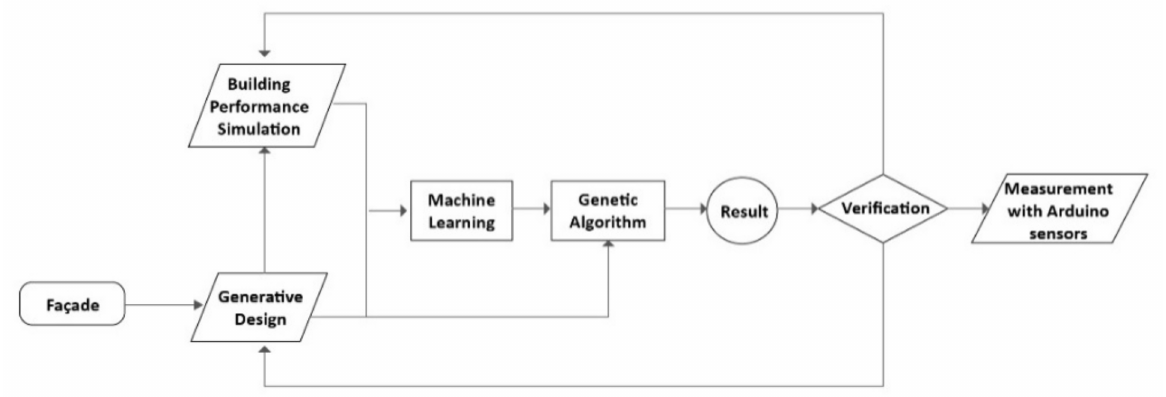
Figure 1. Workflow of the